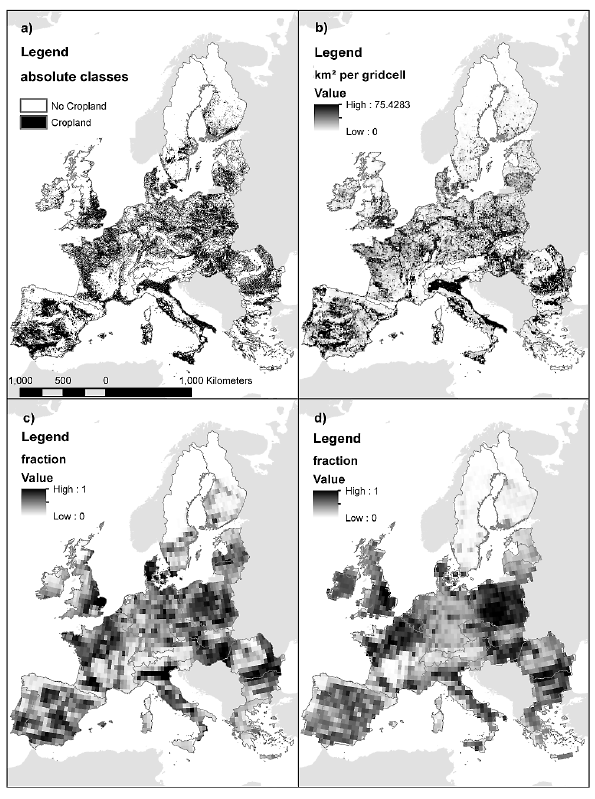
Fig. 7. Model comparison for cropland in the year 1950 for EU27+CH: HILDA (1km by 1km, absolute classes) (a) , Gold- ewijk (0.05 deg, km 2 per grid cell) (b) , Ramankutty (0.5 deg, frac- tions) (c) , Pongratz (0.5deg, fractions) (d)